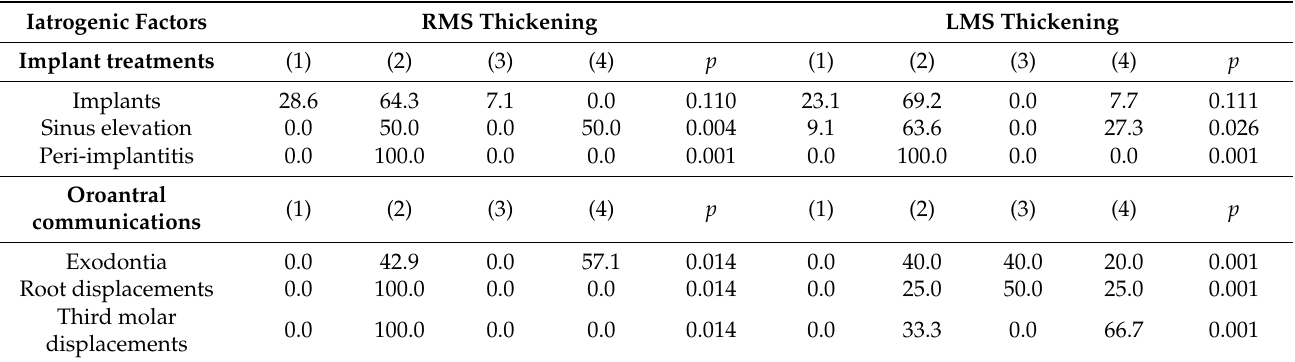
Table 7. Distribution, in percentages, of the thickening of the sinus membrane and its statistical association with iatrogenic